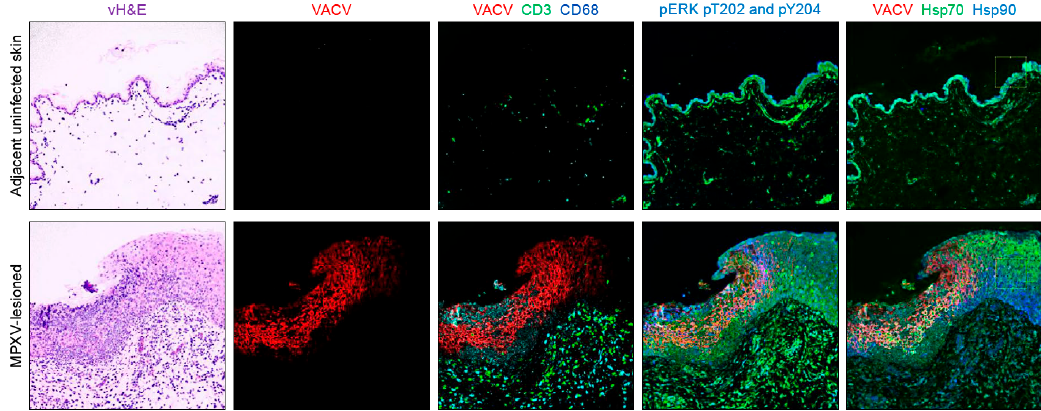
Figure 2. Examples of virtual hematoxylin and eosin (vH&E) and multiplexed staining by Cell DIVE of VACV, CD3, CD68, ERK1 / 2, ERK1 / 2 pT202_pY204, Hsp70 and Hsp90 in archived fixed monkeypox virus-induced skin lesions and in adjacent, nonlesion uninfected